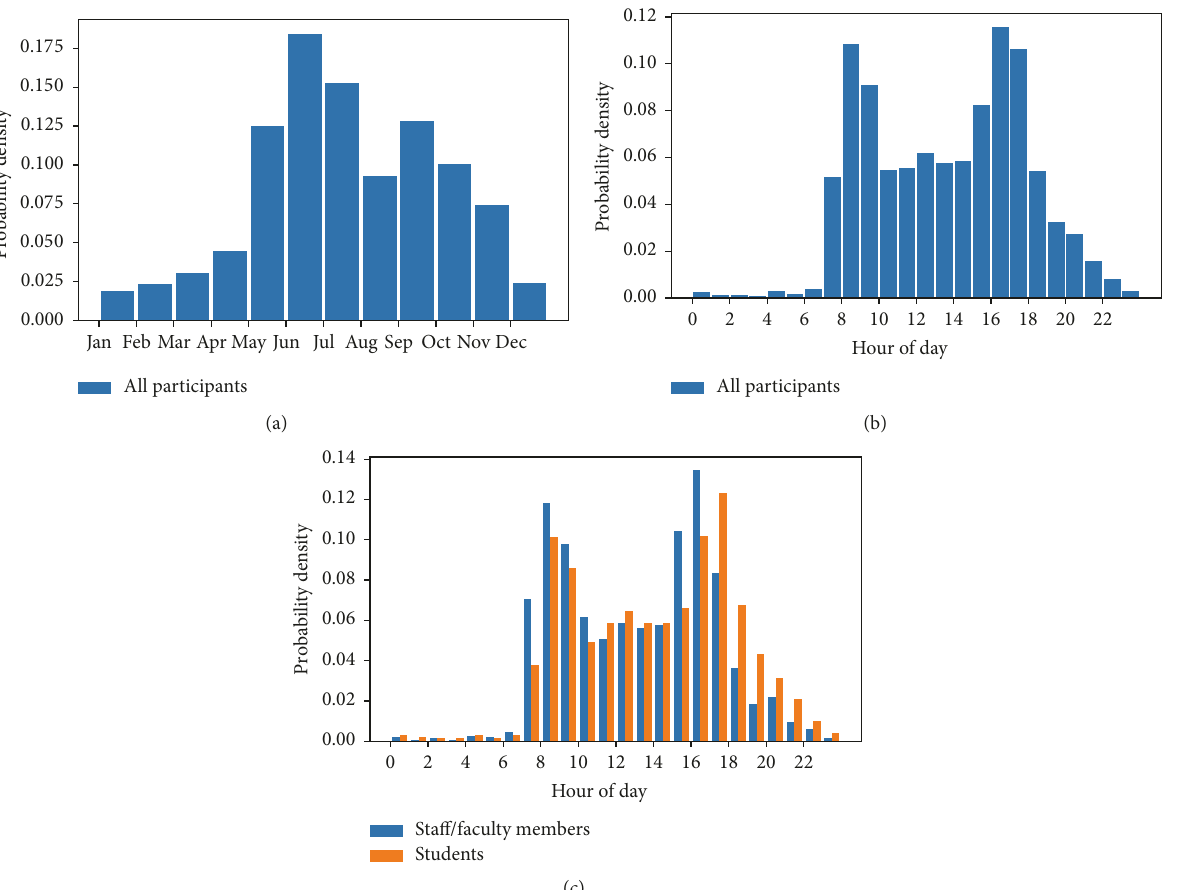
Figure 2: Probability distribution of a trip start (a) on a month-of-year scale, (b) on an hour-of-day scale, and (c) on an hour-of-day scale split by occupation.